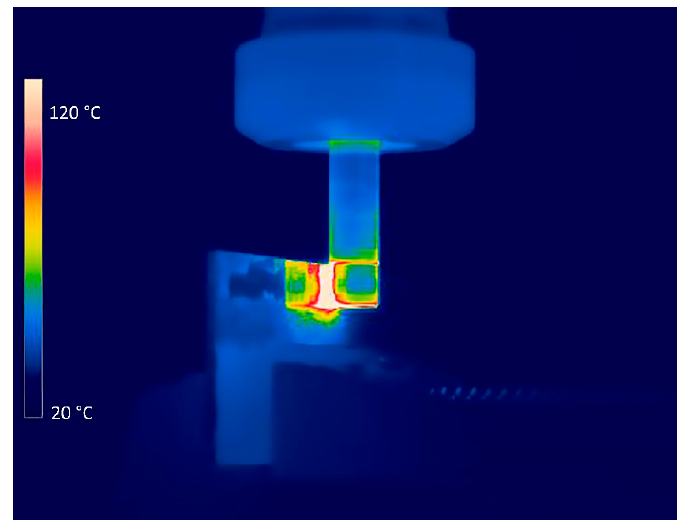
Figure 5. Thermal infrared photo of friction deposition process using side of the consumable tool.